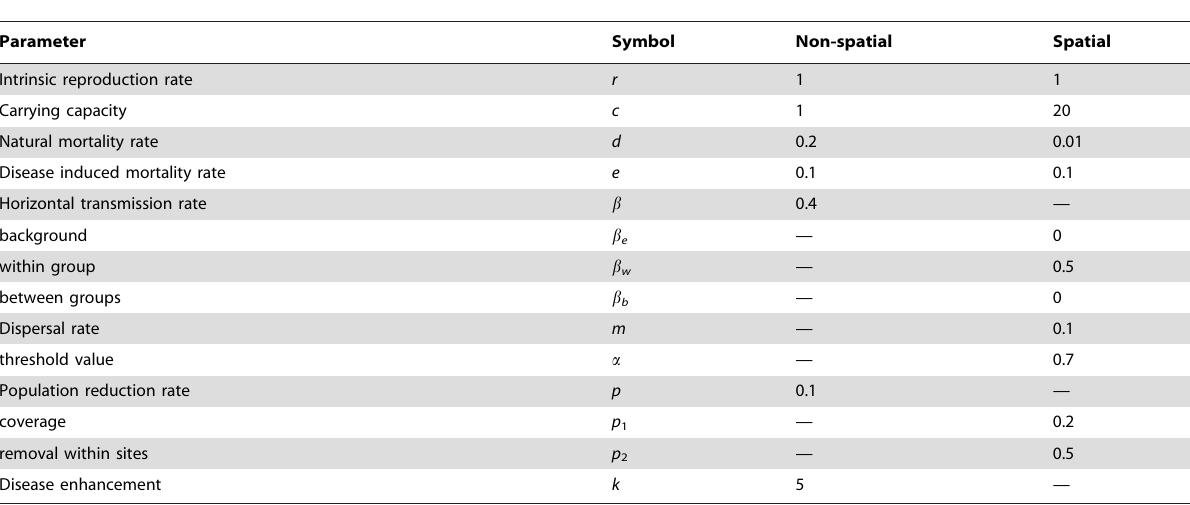
A summary of the parameters and their symbols used in the non-spatial and spatial models are described here. Values shown indicate both the parameters and their default values used in the spatial and non-spatial